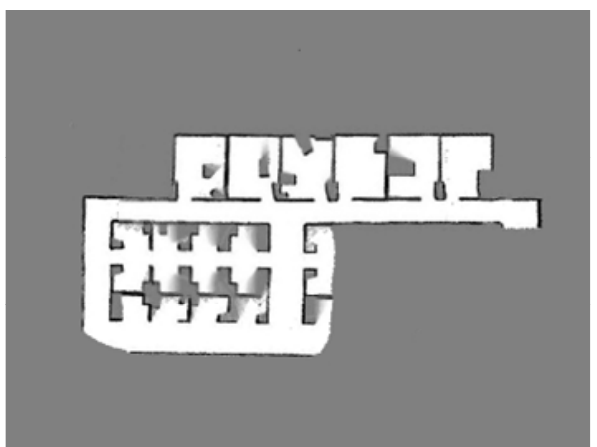
Fig. 7. The successful merging of map 2+3 and map 1 (best hypothesis acceptance indicator 0.898)